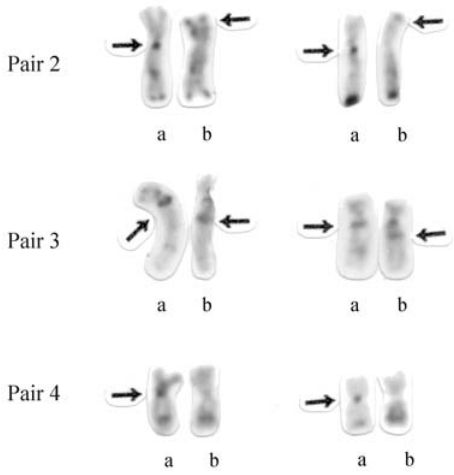
Figure2 -C-bandedheteromorphicchromosomepairs2,3and4fromdif- ferent diploid specimens of Dolichoplana carvalhoi . The arrows indicate the C-banding heteromorphisms. The letters under the chromosomes rep- resent their variants.